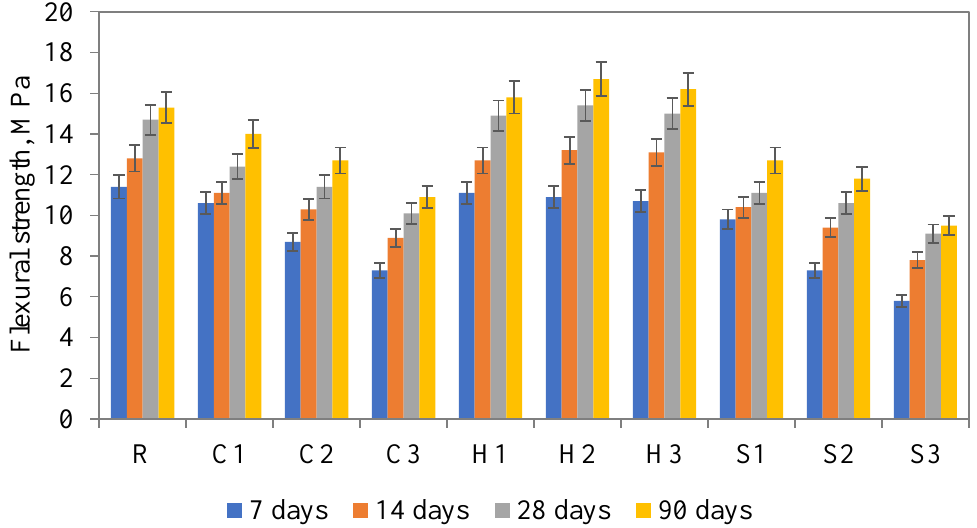
Figure 8. Compressive strength of studied materials.